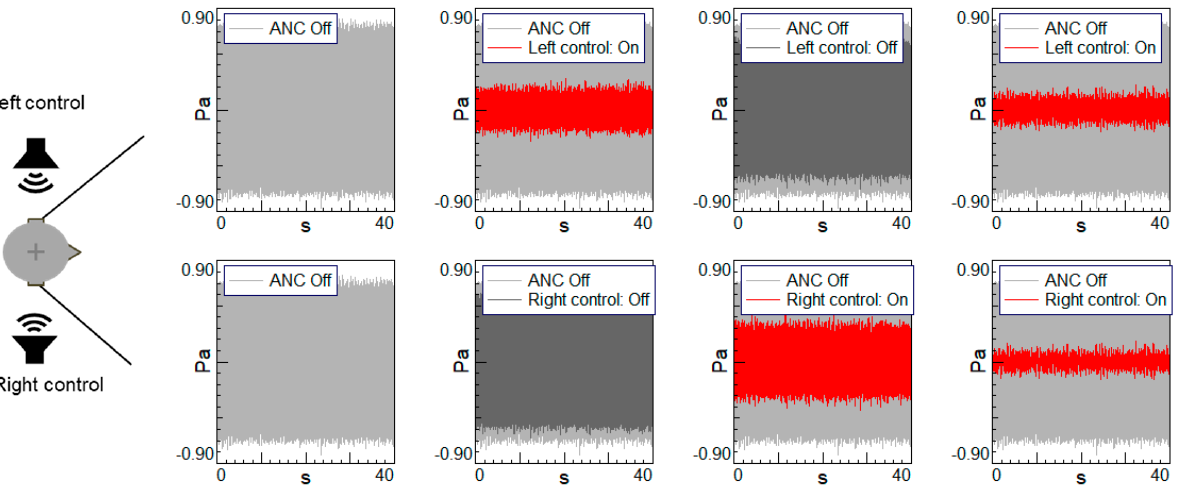
Figure 8. Acoustic signals with/without ANC at left and right mics. Table 1. Sound pressure levels (SPLs) at left and right ears of the binaural head when using ANC. L and R: OFF L: ON, R: OFF L: OFF, R: ON L: ON, R: ON